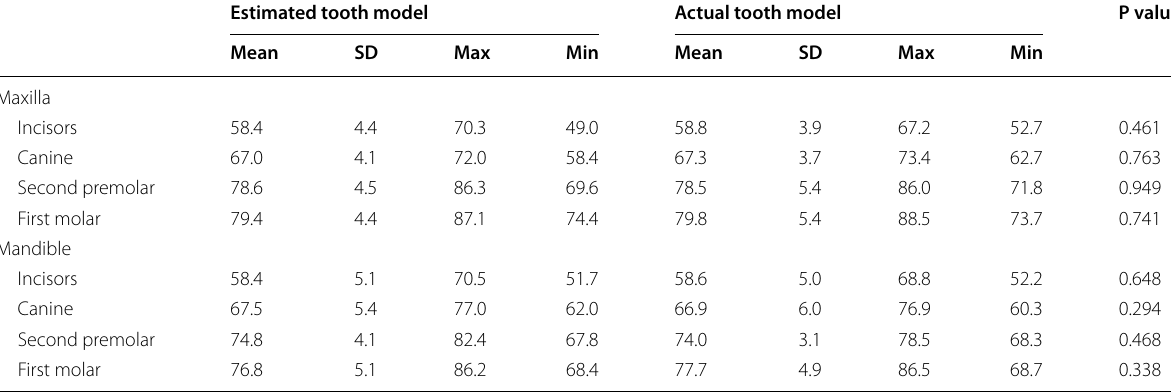
SD, Standard deviation *The results of paired t